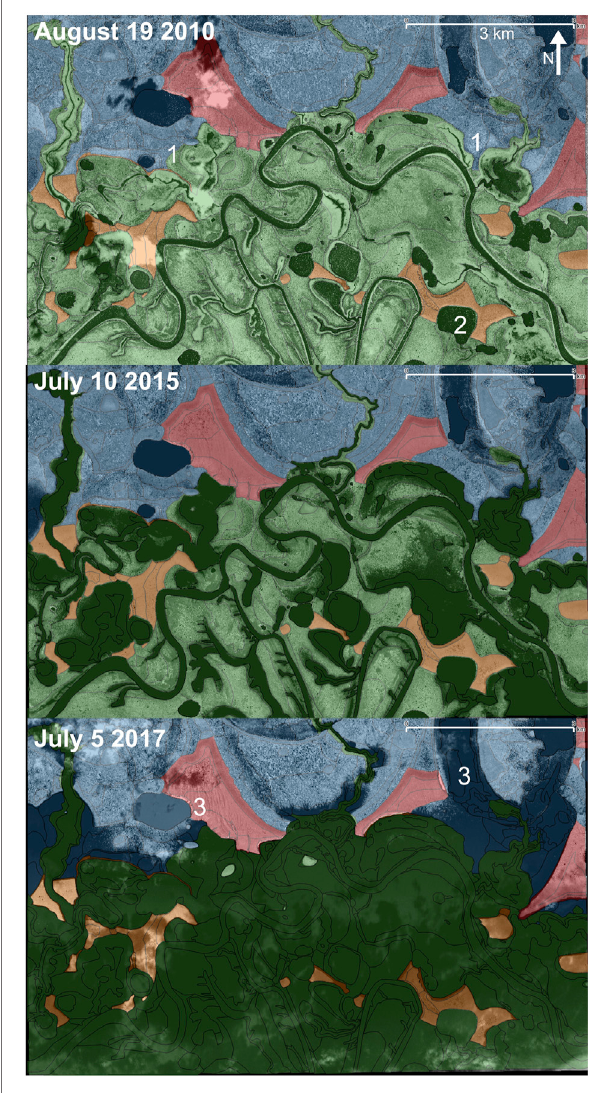
FIGURE 7 | Open water on the river fl oodplain at different river stages. Backdrop: geomorphological map units, see Figure 4 for legend. Top: low stage, end of summer; mid: normal, ± bankfull river stage, below: extremely high fl ood, exceeding the normal fl oodplain limits. 1: river-connected thaw lakes; 2: thaw lake developed on fl oodplain in river terrace; 3: locations where connections between thaw lake and river is developing during high fl ood. WorldView © 2019